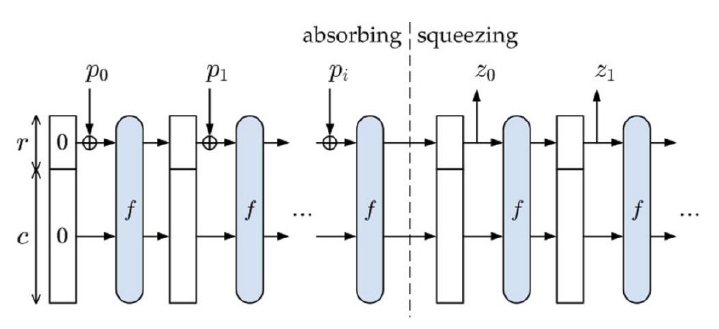
Figure 2. Mechanism of